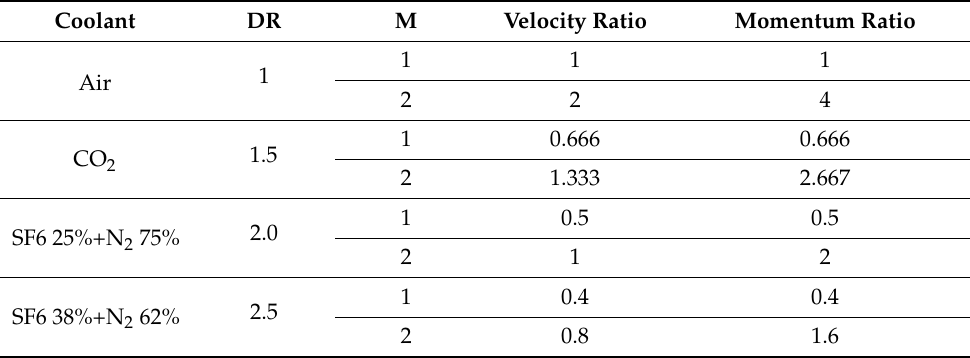
Table 3. Velocity and momentum ratios for various coolant injection conditions.